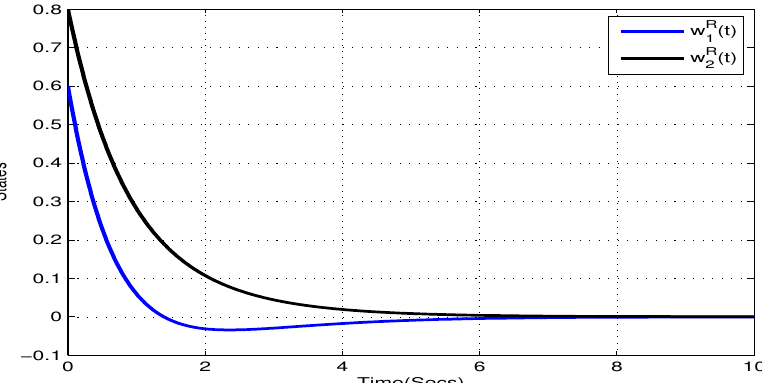
( t ) , w R ( t ) of systems (23) with state feedback control u 2 1